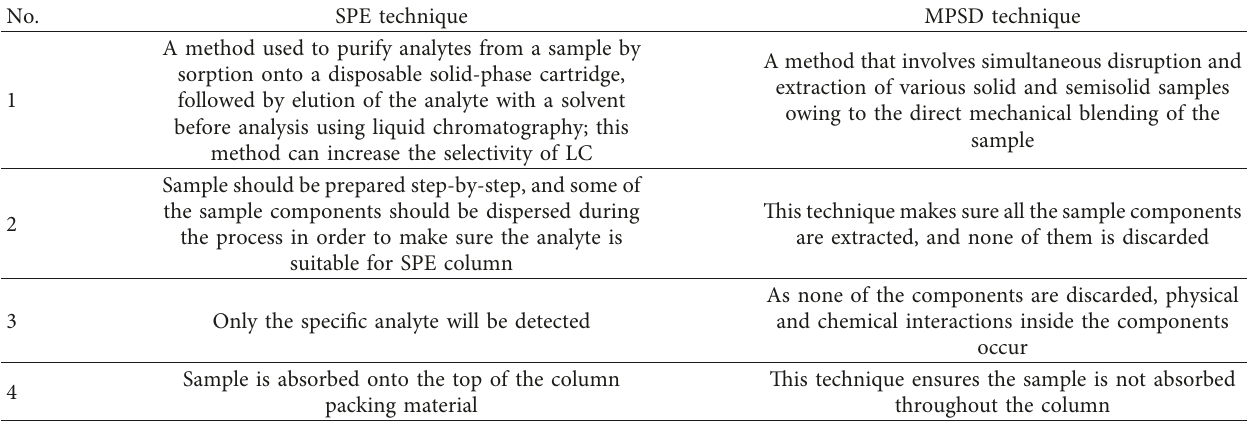
Table 1: The different between solid-phase extraction (SPE) and matrix solid-phase dispersion (MPSD) [14, 15]. No. SPE technique MPSD